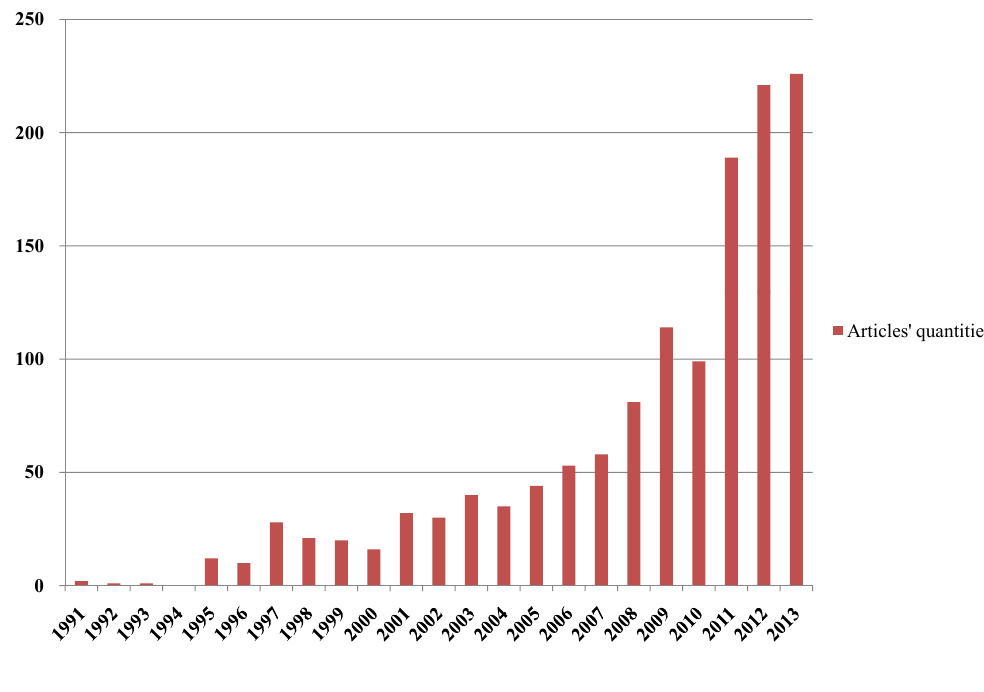
Figure 4. Statistics of the carbon research